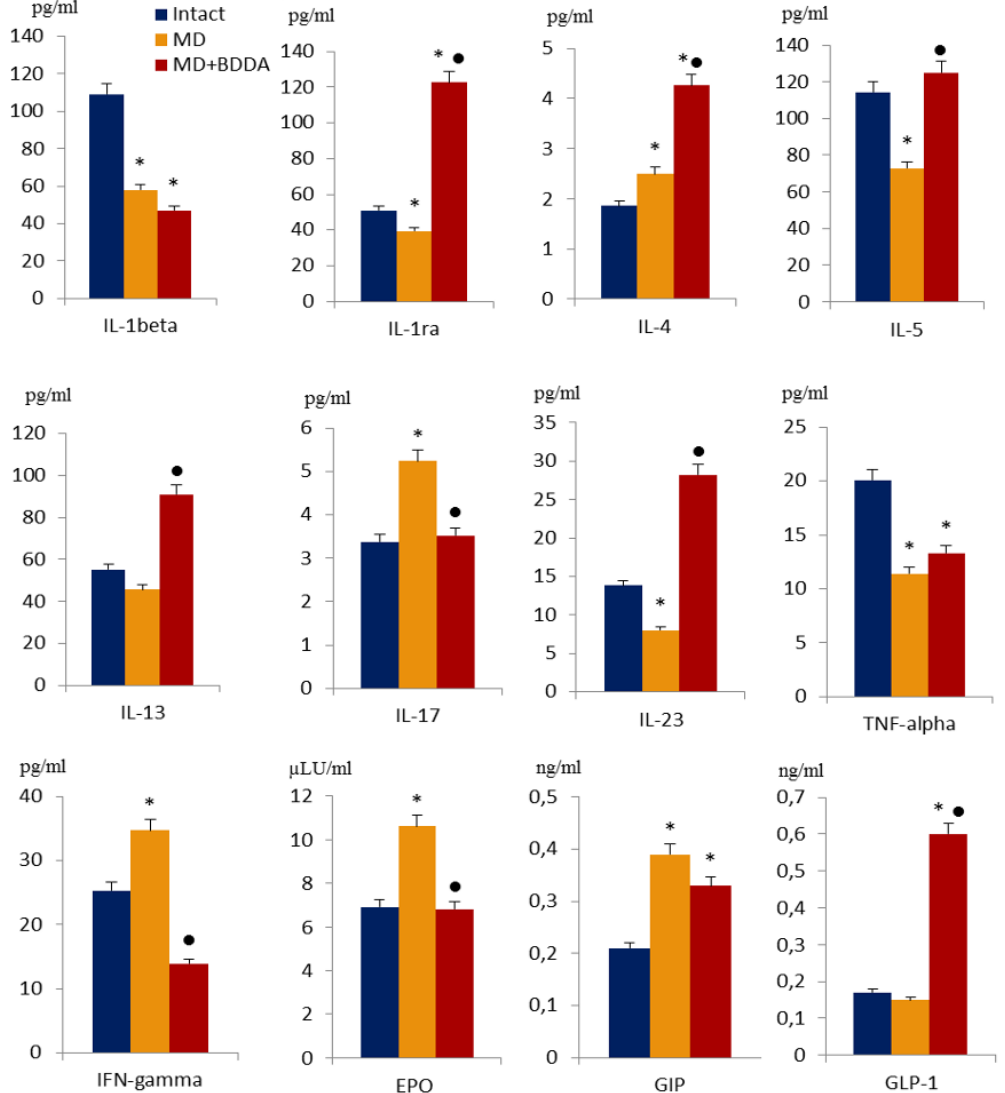
Figure 4. The level of interleukins (1beta, 4, 5, 13, 17, 23), IL-1ra, TNF-alpha, IFN-gamma, EPO, GIP and GLP-1 in the serum of male C57BL/6 mice at d70. Groups: intact—a control group from intact mice, MD—mice with metabolic disorders (MD), MD + BDDA—mice with MD treated BDDA. Results are presented as the mean ± SEM. *: significance of difference compared with intact (p<0.05); ●: significance of difference compared with the MD group ( p < 0.05).